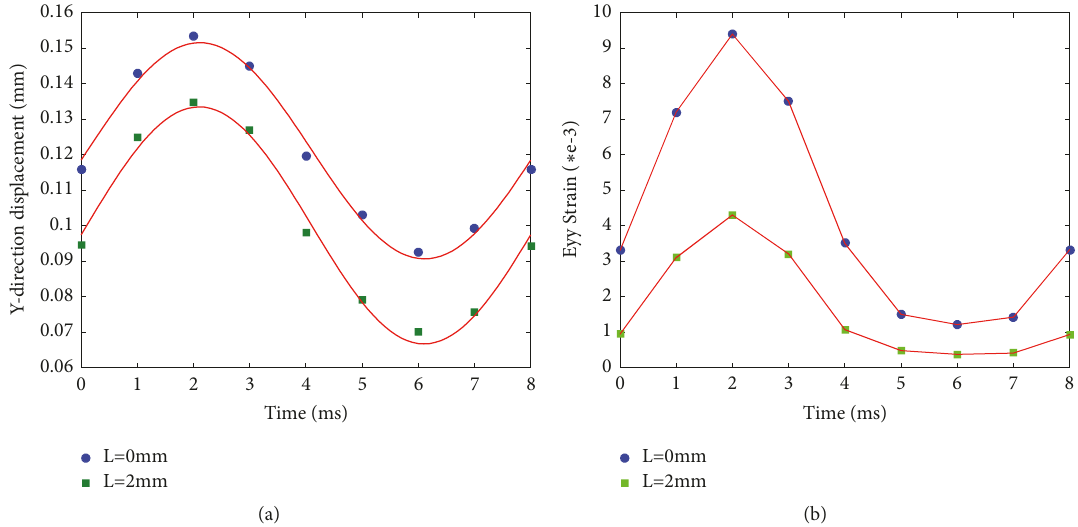
Figure 18: (a) Displacement curves of two points within one stress cycle; (b) strain curves of two points within one stress cycle.